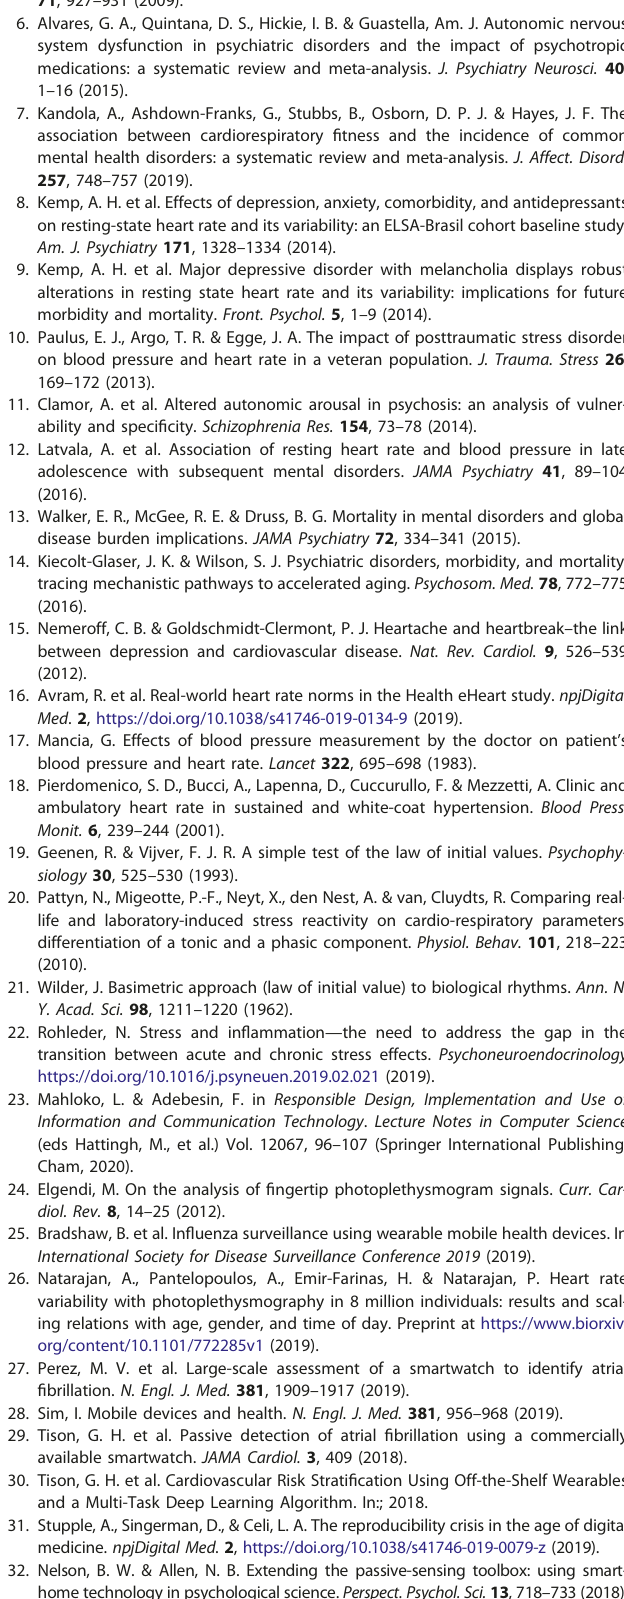
Table 3. mHealth wearable heart rate metadata checklist 2: potential